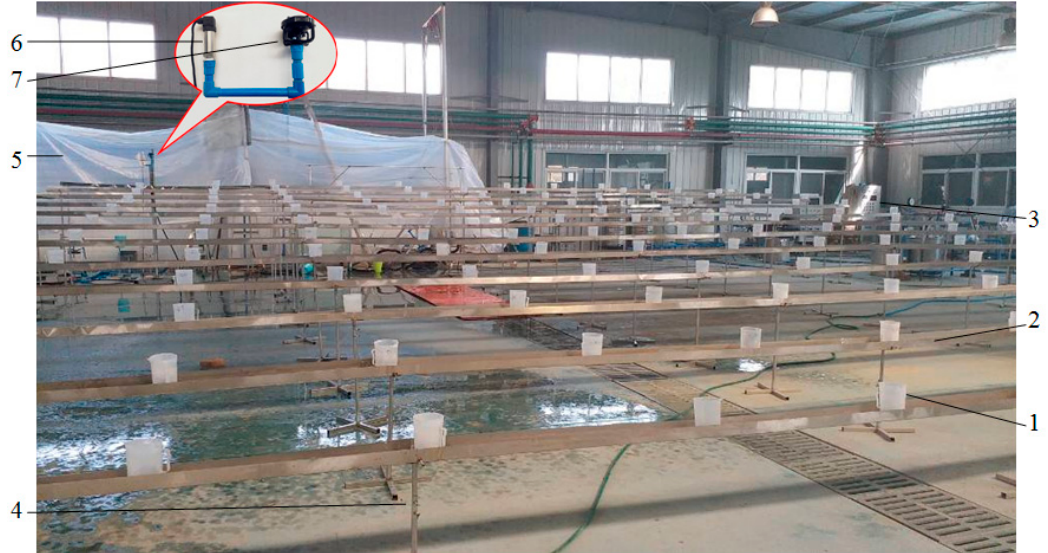
Figure 1. Experimental setup for sprinkler water distribution on sloping ground.